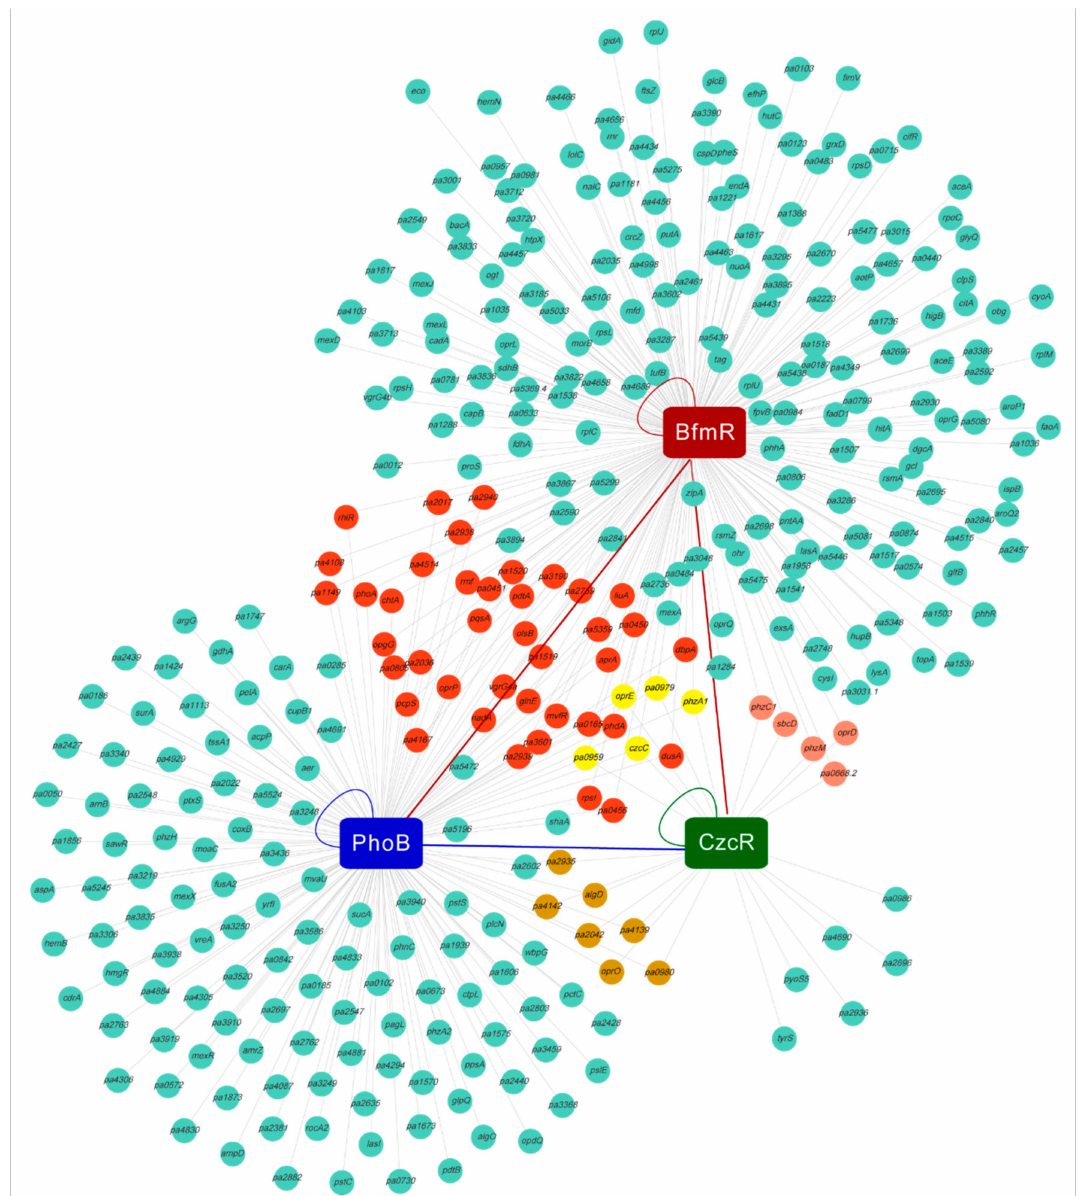
Figure 4. Visualization of promoters bound by BfmR, PhoB, and CzcR. Red circle denotes gene (or the first gene in an operon) whose promoter is co-regulated by BfmR and PhoB; yellow circle, gene co-regulated by BfmR, PhoB, and CzcR; pink circle, co-targeted by BfmR and CzcR; brown circle, co-targeted by PhoB and CzcR. The lines show the connection between the transcription factors and promoters. The curved line represents the binding of the transcription factor to its own promoter [11,53,58,64]. Red lines show the binding of BfmR to the promoters phoB and czcR (Figures 1B, 3A and 5A); Blue line show the binding of PhoB to czcR promoter (Figures 3A and 5A). See Data set 4, Sheet 1 for